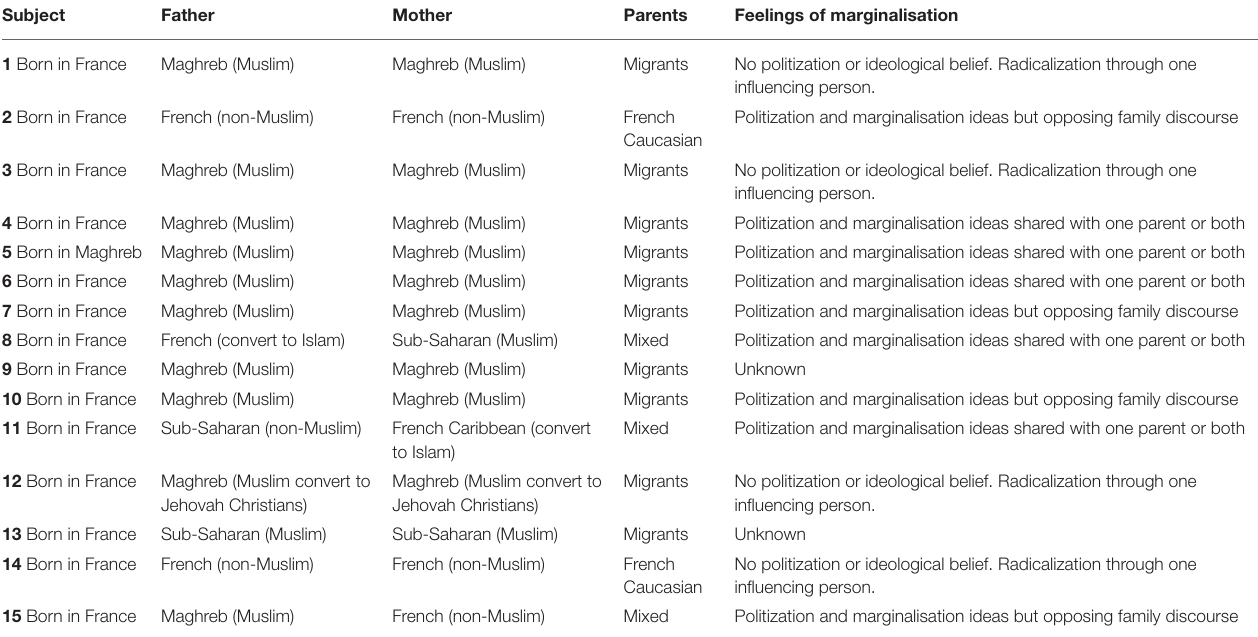
TABLE 1 | Parental origins, Muslim beliefs, and feelings of marginalisation of individuals convicted for “criminal association to commit